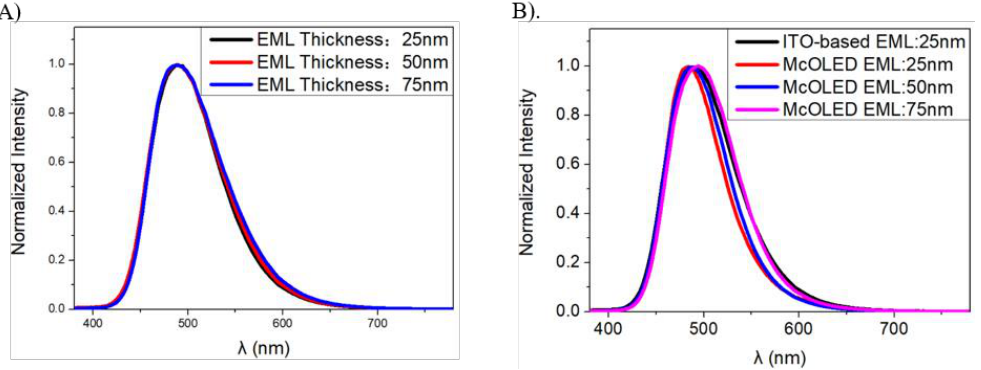
Figure 8. ( A ) EL Spectra of ITO-based OLEDs with EML with 25, 50 and 75 nm thicknesses, and ( B ) EL Spectra of micro-cavity OLEDs (McOLED) with EML with 25, 50 and 75 nm thicknesses.